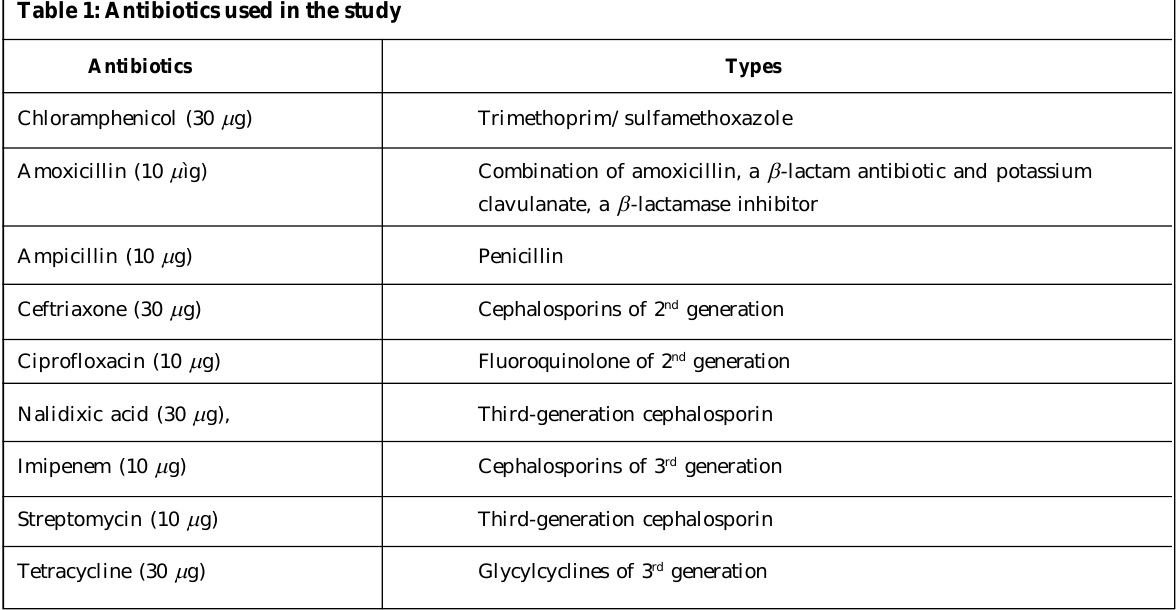
Table 1: Antibiotics used in the study Antibiotics